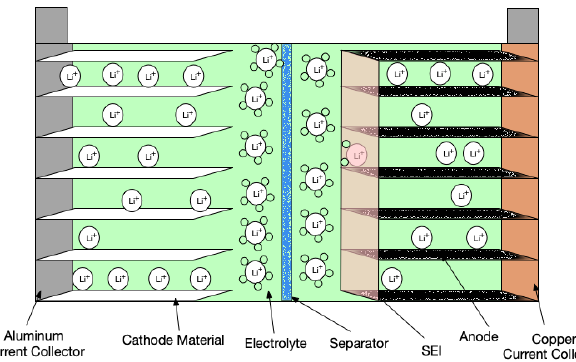
Figure 1. Structure of the battery with manufacturer designed